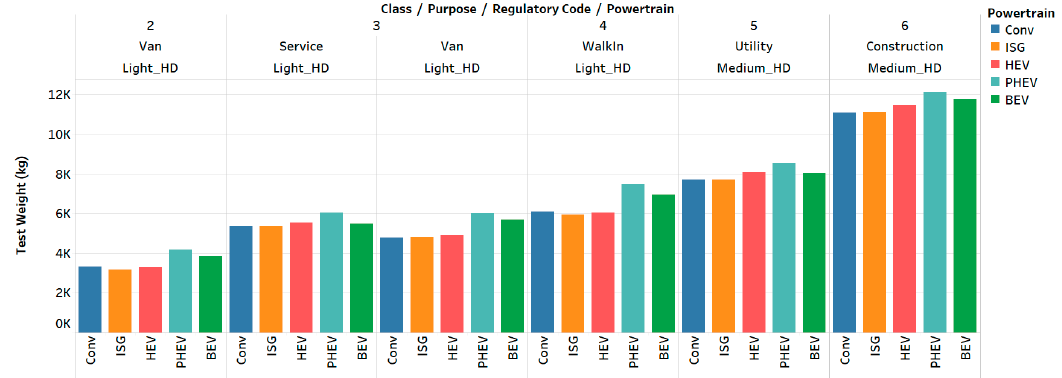
Figure 2. Plug-in electric vehicles (PHEVs) and battery-powered electric vehicles (BEVs) result in vehicles heavier than conventional baseline.